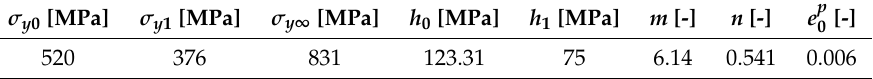
Table 1. Flow curve data of P91 at room